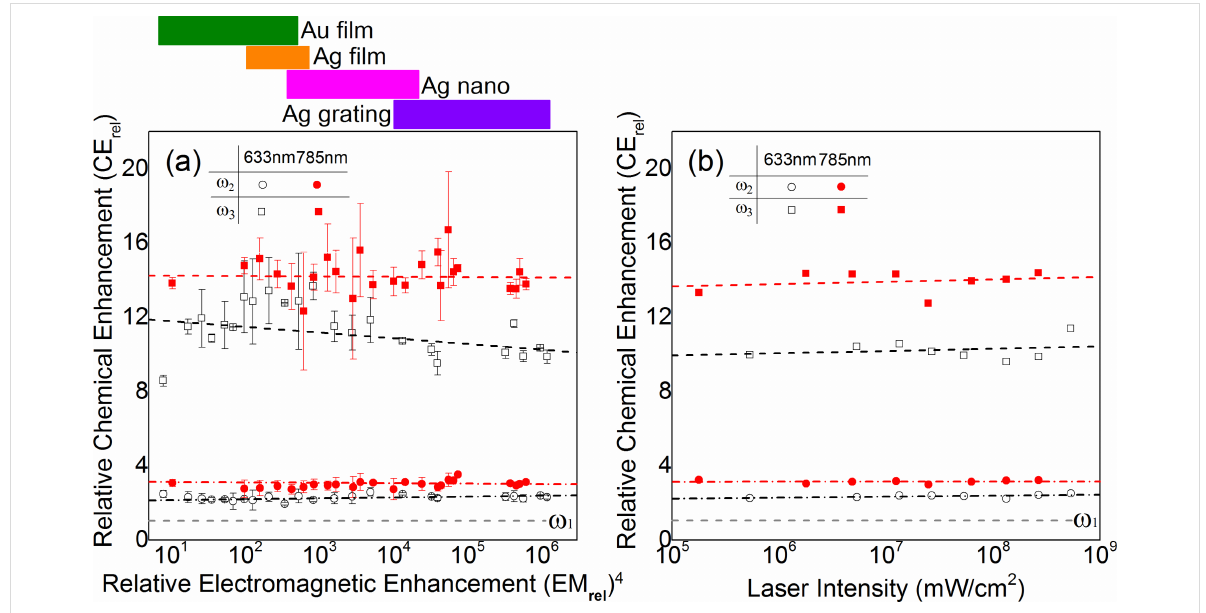
Figure 3: (a) Relative Chemical enhancement (CE rel ) factor versus relative electromagnetic enhancement (EM rel ) for different substrates with 633 nm (black) and 785 nm (red) excitation (with incident laser power of 2 × 10 7 mW/cm 2 ) ω 2 and ω 3 . (b) Chemical enhancement as a function of incident laser intensity for the Ag nanosubstrate with 633 nm (black) and 785 nm (red)